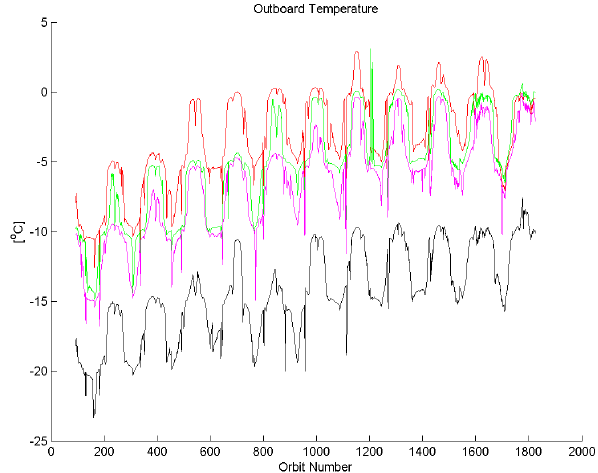
Figure 3. Electronics box temperatures in degrees Celsius for each spacecraft for orbits 93–1889 (February 2001–August 2012). C1 – black, C2 – red, C3 – green, C4 –